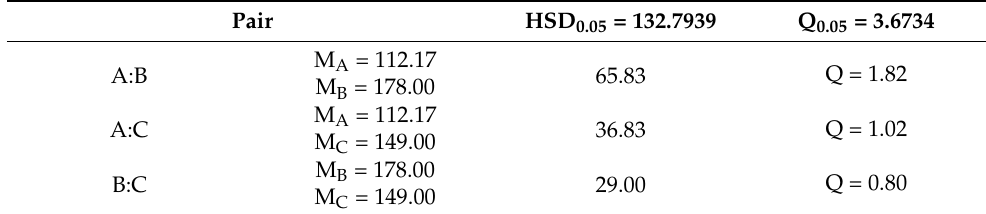
Table 14. Pairwise comparisons of sawing process variants with Tukey